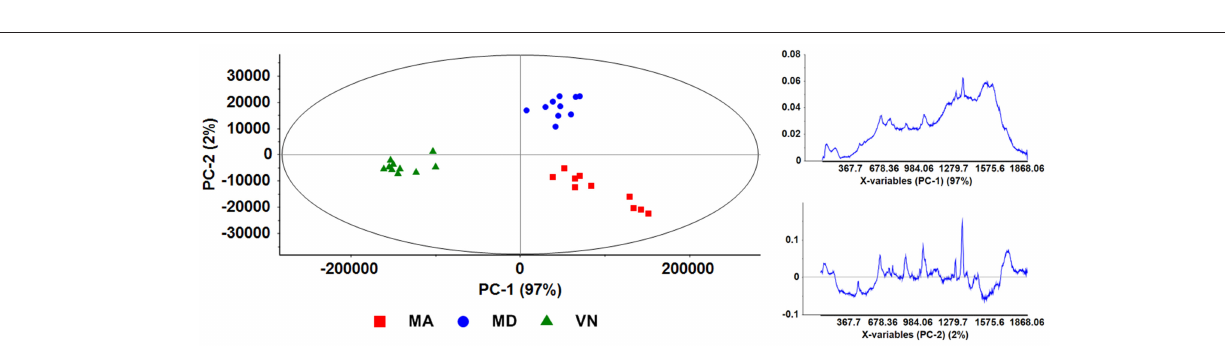
Frontiers in Chemistry |